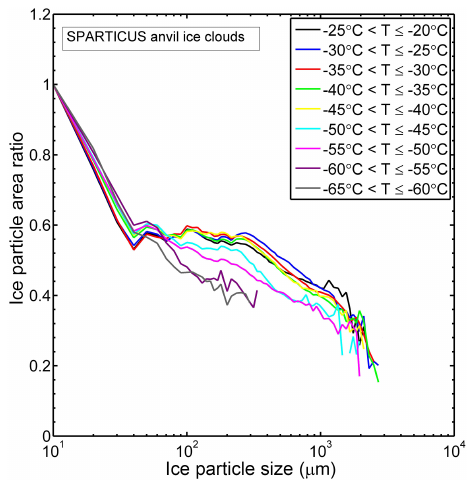
Figure 10. Mean area ratios for each mean PSD size bin are shown as a proxy for ice particle shape. Temperature intervals correspond- ing to each mean PSD are indicated for synoptic ice clouds.